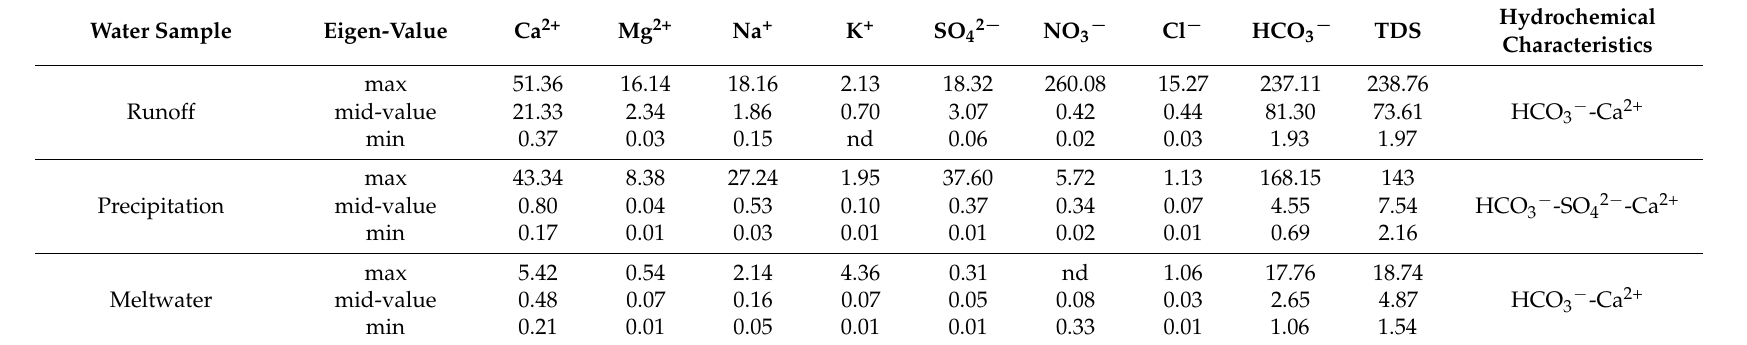
Note: nd indicates that the concentration was not detected and was lower than the instrument detection